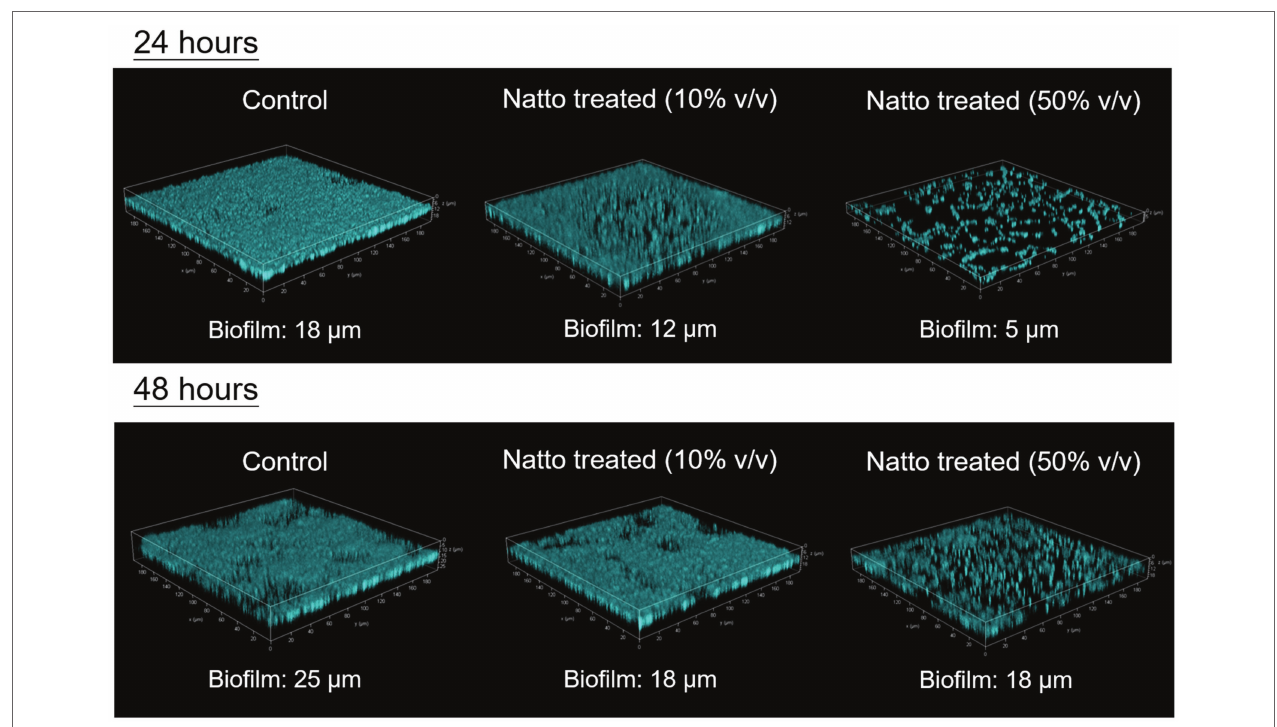
FIGURE 4 | 3D architecture of E. faecalis OG1RF::p23cfp biofilms with or without B. subtilis natto supernatant. The CFP-expressing strain E. faecalis OG1RF::p23cfp was cultured anaerobically in M9B medium without or with B. subtilis natto supernatant (0, 10, or 50% v/v) on glass coverslips in tissue culture dishes. After 24 or 48 h of cultivation, the biofilms that formed on the bottom of the culture dishes were washed, fixed, and then analyzed using CLSM. The approximate biofilm thicknesses ( μ m) for all groups were measured and are shown in the